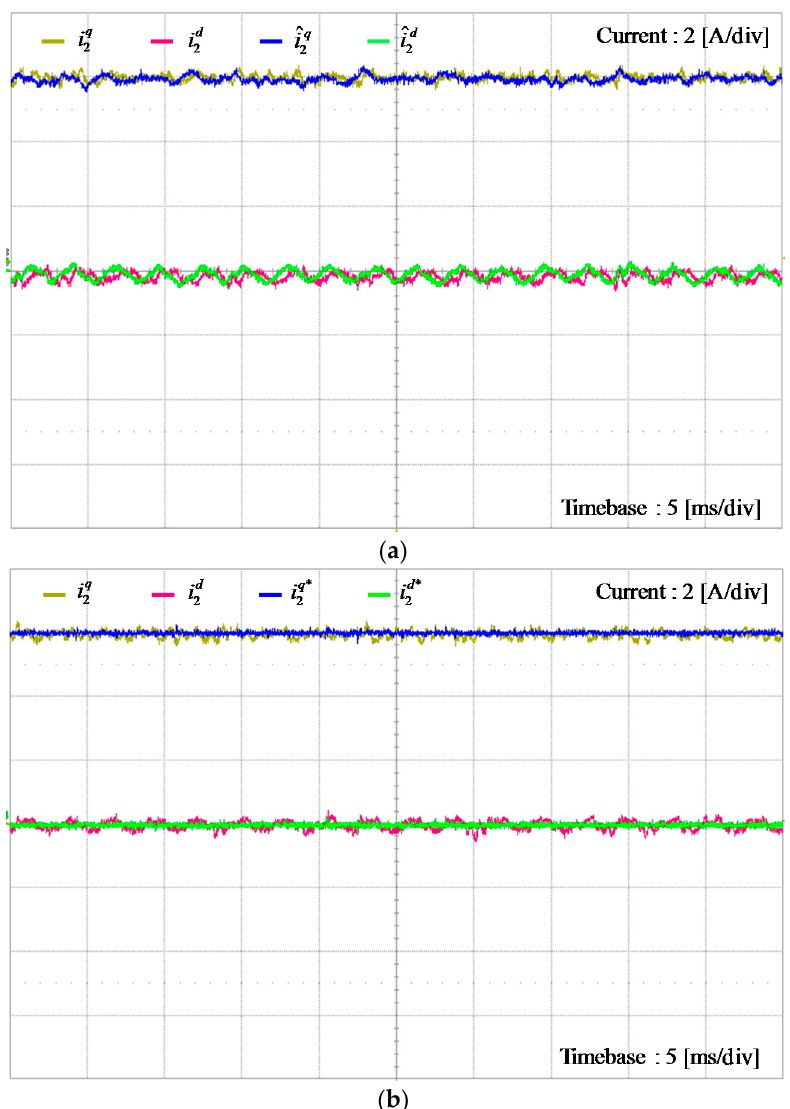
Figure 12. Experimental results for the proposed discrete-time integral state feedback control scheme with state observer. ( a ) Measured and estimated grid-side currents at the SRF; ( b ) Grid-side reference currents and measured grid-side currents at the SRF.